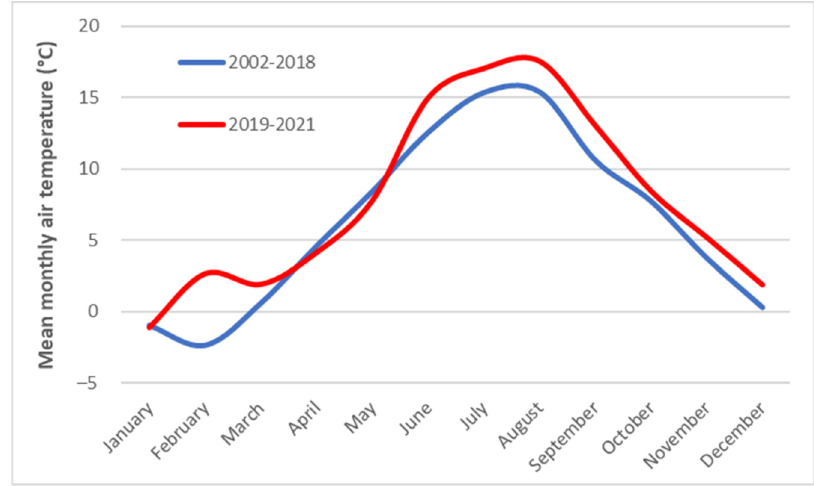
Figure 5. Mean monthly air temperature for the years 2019–2021, and comparison with the period 2002–2018. Data from Sibilla Mountain meteorological